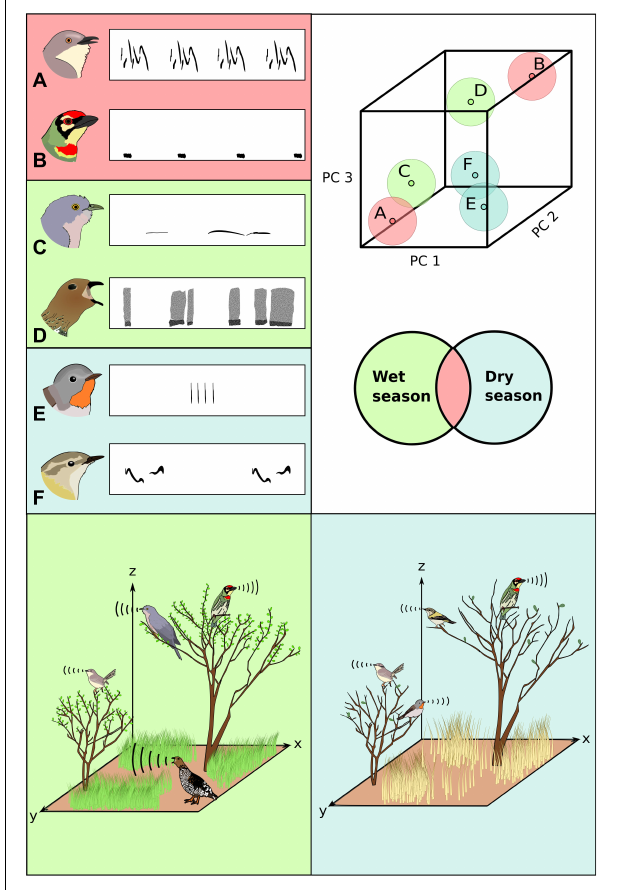
FIGURE 1 | Signal space (top right), derived using principal components analysis on acoustic signal parameters of diverse species ( A–F , top left) enables study of acoustic communities across spatiotemporal scales, including different seasons (color codes). Signal space for each species is represented as the volume occupied by the entire repertoire (larger circles, with the smaller point representing the centroid). Bottom panels: Acoustic community structure varies along both spatial and temporal axes (color codes represent different seasons). This figure loosely depicts some bird species from an acoustic community in western India for illustrative purposes, demonstrating seasonal turnover, with species replacing each other, and spatial segregation, with each species singing from a preferred location in space (Krishnan,